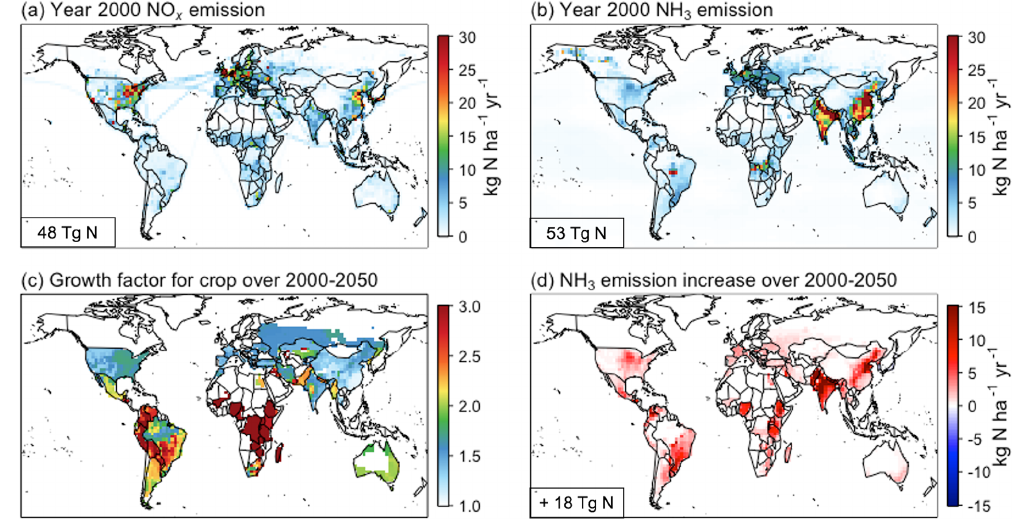
Figure 2. Global year 2000 emissions of (a) NO x and (b) NH 3 , (c) the growth factor g of crop production increase over 2000–2050 from the Food and Agriculture Organization of the United Nations (FAO), (d) and the projected increases in NH 3 emissions over 2000–2050. Table 2. Experimental design to quantify surface ozone responses to terrestrial changes including leaf area index (LAI), canopy height, and soil NO x emissions. [CTR] [LAI] [HTOP] [NOX] [ALL] LAI Year 2000 Year 2050 Year 2000 Year 2000 Year 2050 Canopy height Year 2000 Year 2000 Year 2050 Year 2000 Year 2050 Soil NO x Year 2000 Year 2000 Year 2000 Year 2050 Year